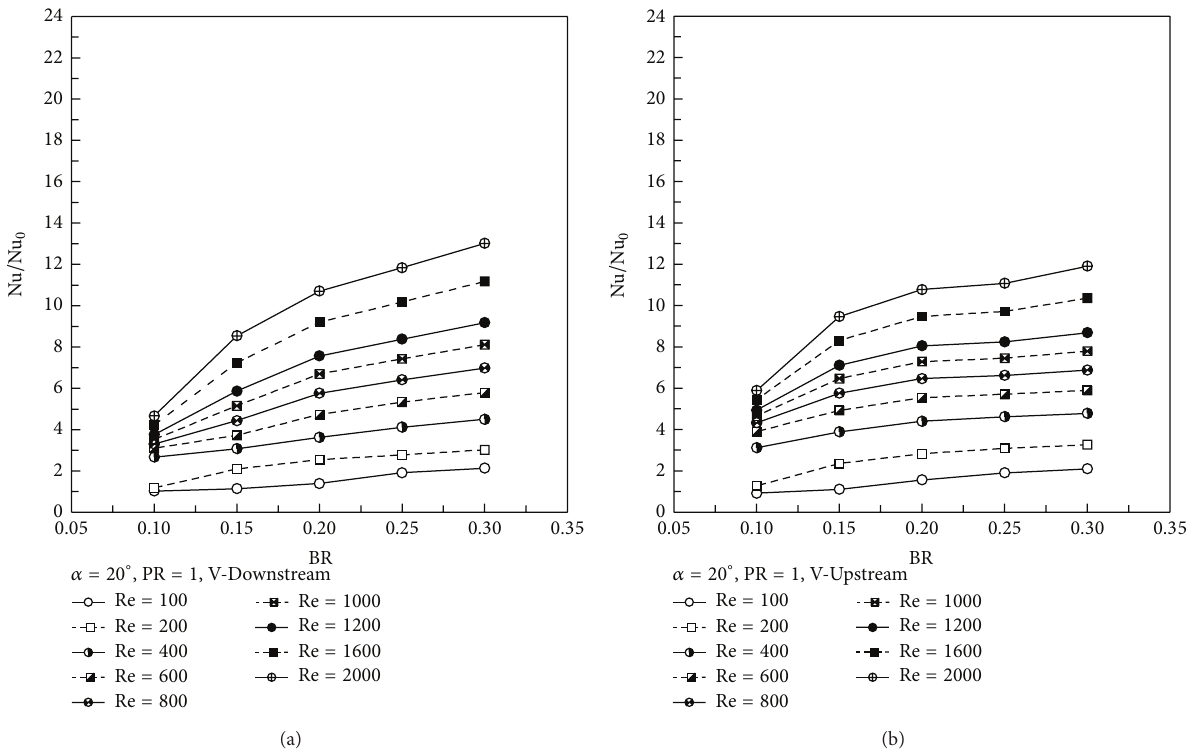
Figure 10: Nu / Nu 0 versus BRs at various Reynolds number values for (a) V-Downstream and (b) V-Upstream.